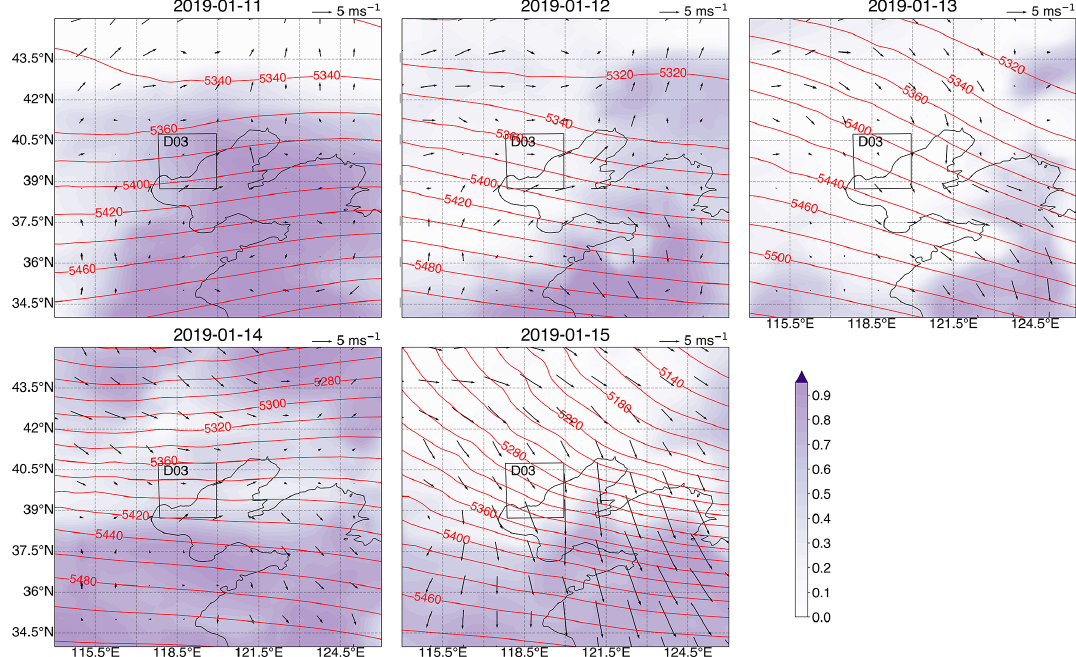
Figure 2. The daily averaged geopotential height (contour lines, units: gpm) at 500hPa, total cloud fraction (shading), and surface winds at 10m (vectors, units: ms − 1 ) from ERA5 during 11–15 January 2019; the box indicates the D03 domain in Fig. 1.